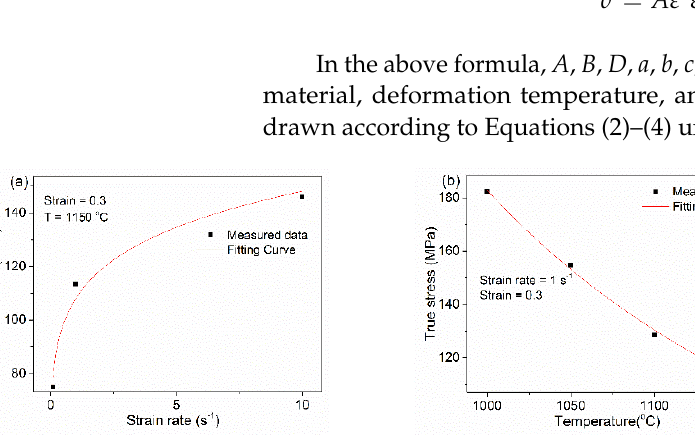
Figure 4. Regression results of the flow stress with different parameters. ( a ) Strain rate; ( b ) temperature; ( c ) strain.